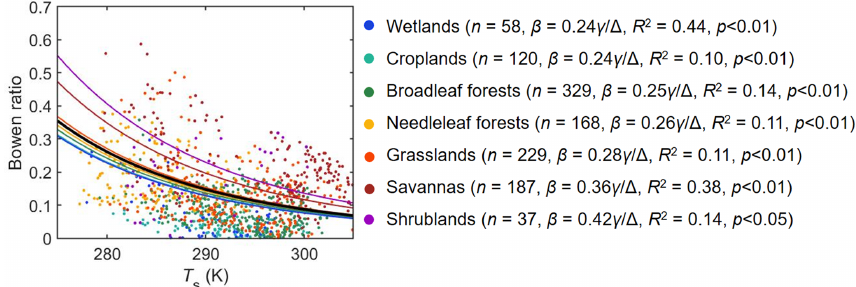
Figure 2. Relationship between Bowen ratio ( β ) and surface temperature ( T s ) over saturated land surfaces. The thick black curve represents the fitted β – T s relationship across all data points (i.e., n = 1128, β = 0 . 27 γ/(cid:49) , R 2 = 0 . 11, p < 0 . 001), and the colored lines represent different biome types with the number of data points ( n site-days) and fitted β – T s relationship for each biome type shown in the legend.